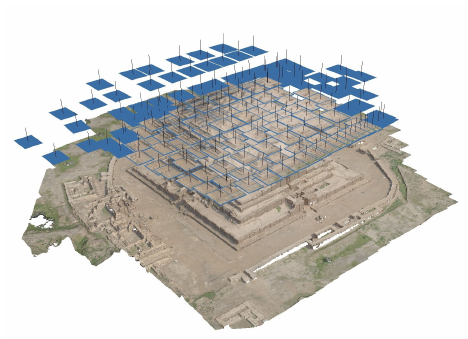
Figure 9. Camera poses of NUAV Data